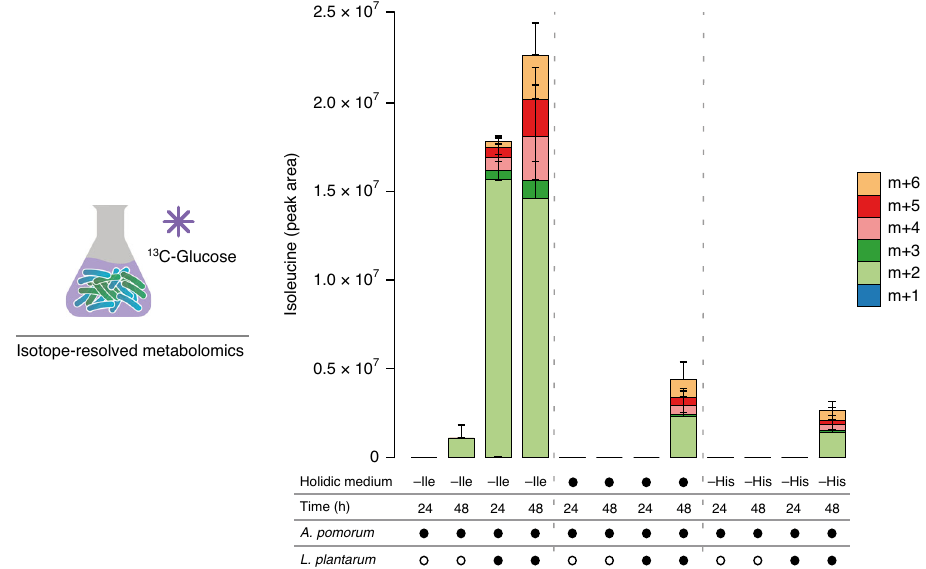
Fig. 3 Ap synthesises and secretes isoleucine in the presence of Lp . The stacked bars represent the relative amount of Ile isotopologues measured in the supernatant of liquid holidic medium of bacterial cultures grown in holidic medium lacking Ile (-Ile, left section), complete holidic medium ( fi lled black circles, central section) or His (-His, right section) all containing uniformly labelled 13 C-glucose. Heavy-labelled Ile isotopologues were measured using LC – MS in samples collected after 24 h or 48 h of bacterial growth and displayed as metabolite peak area. The number of heavy carbons incorporated per Ile molecule is indicated as m + n , where m = molecular mass of the metabolite and n = the number of 13 C. Filled black circles represent the presence of speci fi c bacteria in the culture. Open black circles represent the absence of speci fi c bacteria. For each condition three independent bacterial cultures were sampled at 24 h and 48 h. The plots represent the mean amount of the detected isotopologues per condition and the error bars represent the s.e.m. Source data are provided as a Source Data fi le.